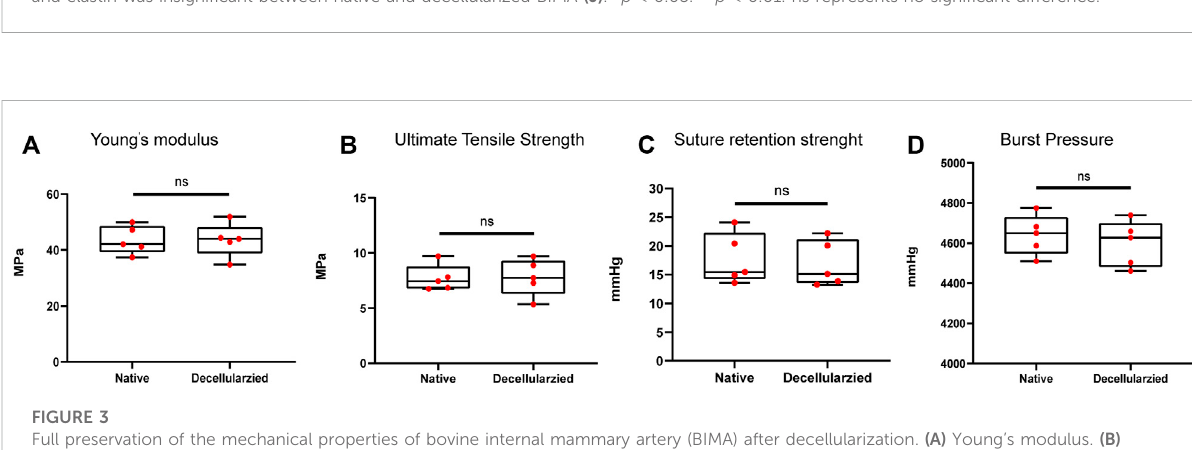
Frontiers in Bioengineering and